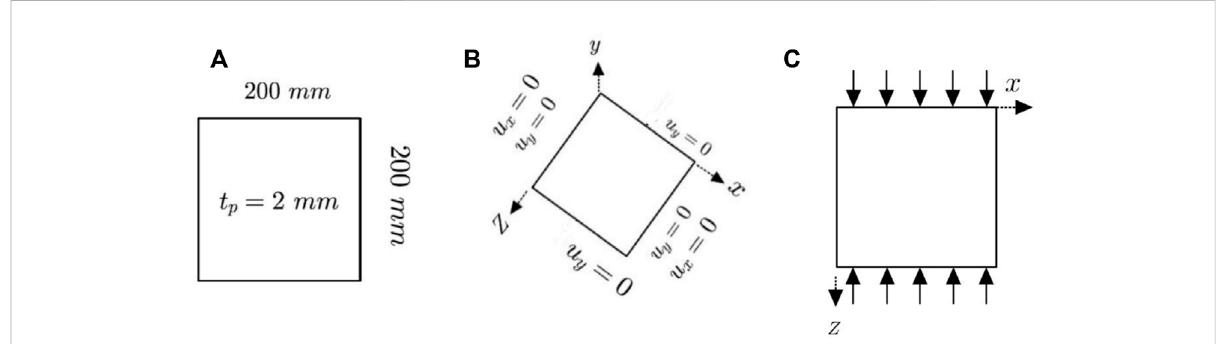
FIGURE 2 (A) Plate geometry, (B) plate boundary conditions, (C) plate